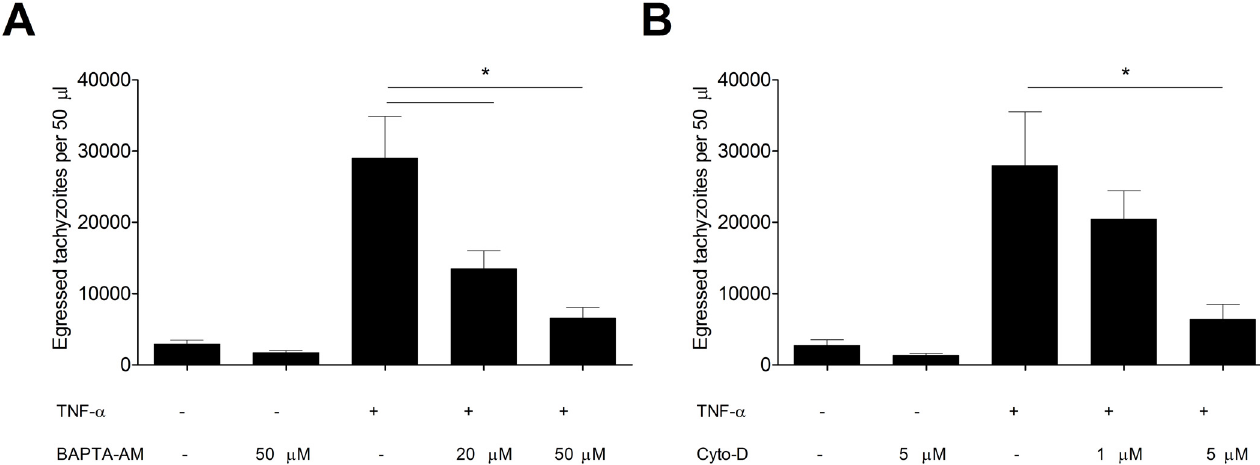
Figure 2. Parasitic motility and intra-parasitic calcium were required for TNF- a -induced egress of T. gondii . Infected HFFs (36 h) were pre-treated with BAPTA-AM (A) or Cyto-D (B) before the TNF- a -induced egress assay (10 ng/mL, 6 h, as described in Fig 1). Bars represent means ± SDs of fi ve replicates. This experiment was repeated three times with similar results, * p < 0.05.